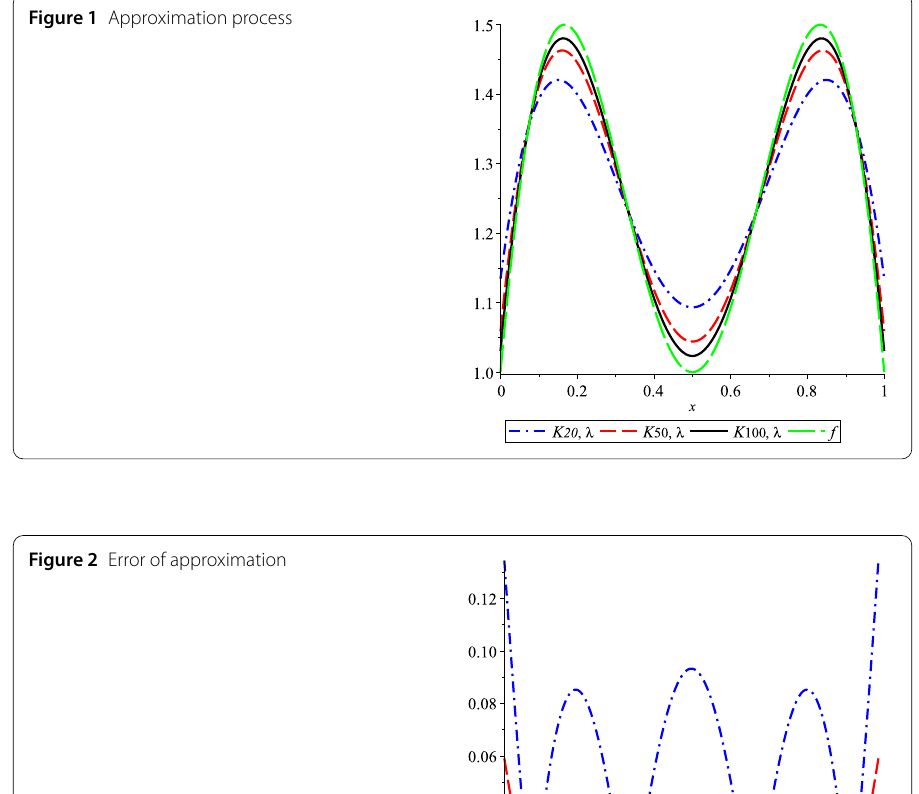
Figure 1 Approximation process